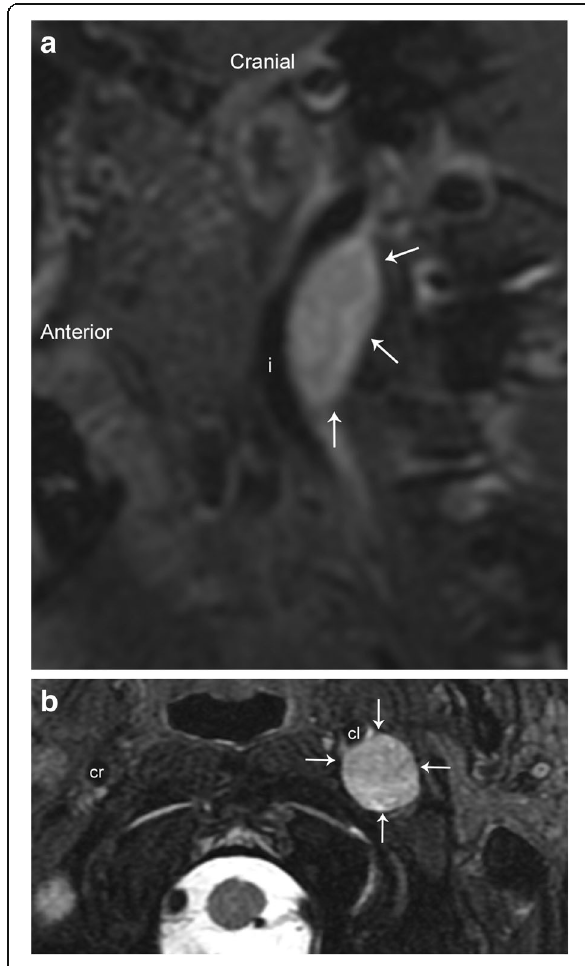
Fig. 5 Glomus vagale. a Sagittal T1-weighted fat-saturated post-contrast image demonstrates anterior displacement of the left internal carotid artery (i) by a well-circumscribed and enhancing mass (arrows). b Axial T2- weighted fat-saturated image demonstrates the lesion to be hyperintense (arrows), causing anterior displacement of the left internal carotid artery (cl). The normal position of the right internal carotid artery (cr) is also